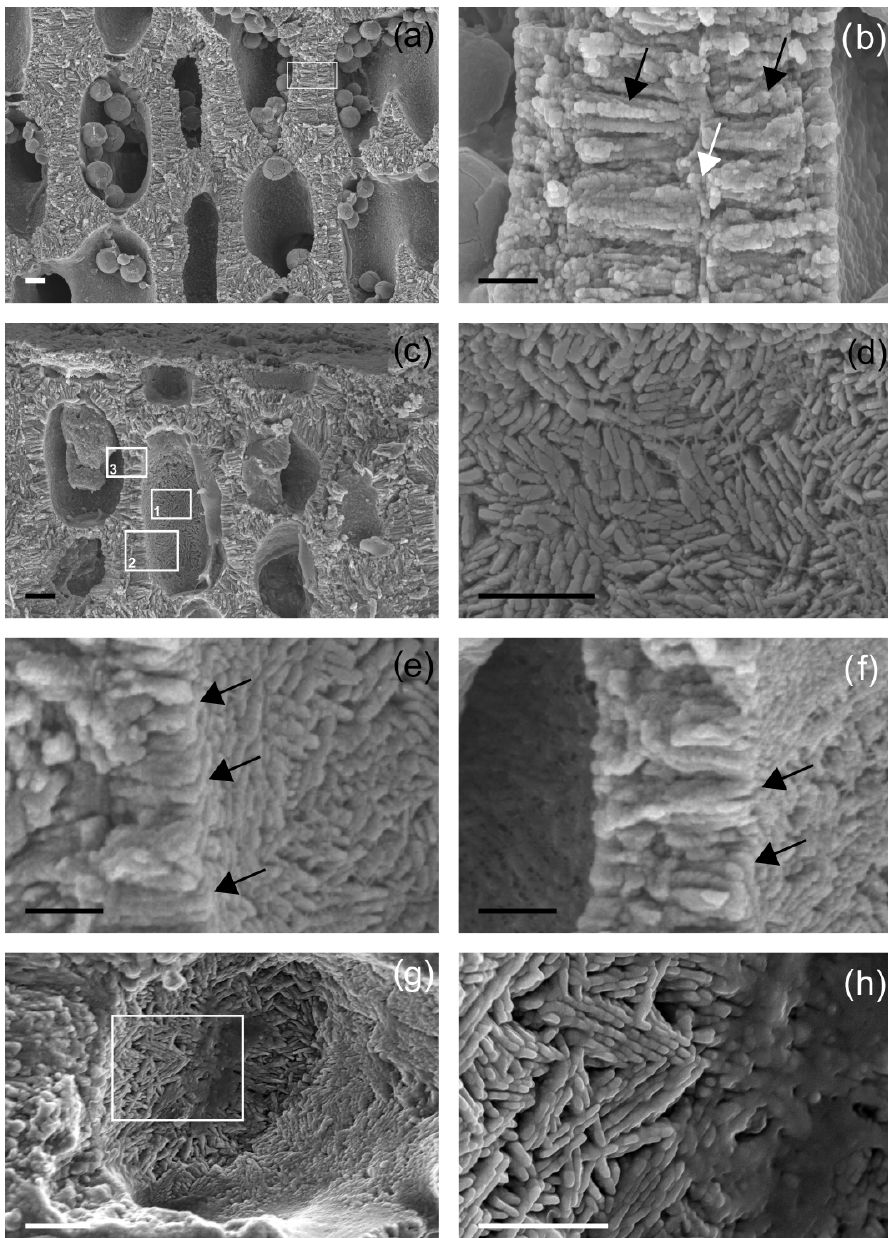
Figure 7. Details of secondary wall (SW) in longitudinal section. (a) Thick-walled short cells showing both PW and SW for Morlaix Bay. Scale bar = 2µm. The inset is magnified in (b) ; (b) very thin PW (white arrow) and SW (black arrows) in cell walls of two adjacent cells. The SW is characterized by elongated radial crystals formed by the fusion of smaller roundish units, in places showing an apparent multi- layered structure, for Morlaix Bay. Scale bar = 1µm. (c) Perithallial thick-walled cells showing both PW and SW, as well as single flattened epithallial cells, for Morlaix Bay. Inset 1 is magnified in (d) , inset 2 in (e) and inset 3 in (f) . Scale bar = 2µm. (d) The SW as visible in lumen cell with no membrane. In this view the crystals appear to be ovoidal to rod-shaped with a complex orientation associated with fibrils for Morlaix Bay. Scale bar = 1µm. (e) The SW as visible in lumen cell with no membrane. A section showing at the same time a longitudinal section of the cell wall (on the left) and the inner surface of the lumen cell (on the right). This perspective provides the actual 3D shape of the SW crystals that are thin bricks (black arrows) for Morlaix Bay. Scale bar = 1µm. (f) The SW as visible in lumen cell with no membrane. A section showing at the same time a longitudinal section of the cell wall (center) and the inner surface of the lumen cell (on the right). This perspective provides the actual 3D shape of the SW crystals that are thin bricks (black arrows) for Morlaix Bay. Scale bar = 1µm. (g) A detail of the SW as visible inside a cell lumen. The crystals are thin bricks with a complex zigzag and cross orientation. The inset is magnified in (h) for Egadi Islands. Scale bar = 2µm. (h) A zigzag and cross orientation of bricks in the SW for Egadi Islands. Scale bar =